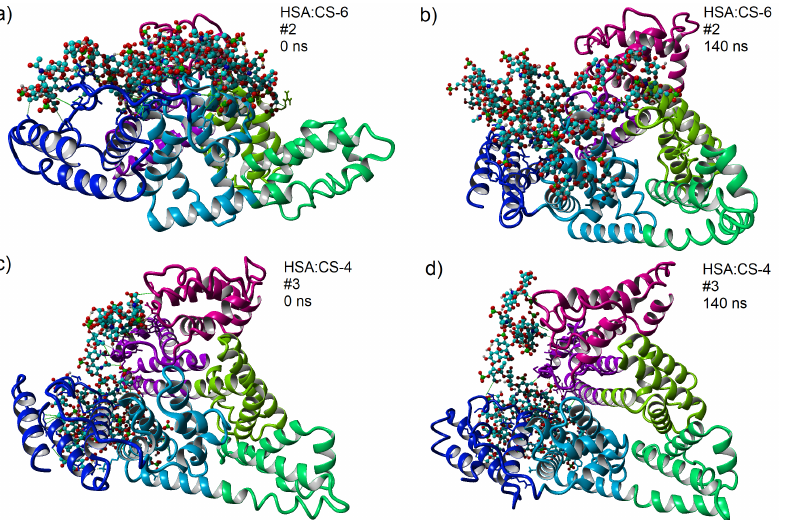
Figure 5. 3D structures of HSA:CS-6 ( a , b ) and HSA:CS-4 ( c , d ) complexes for the strongest bound complexes after MD in CaCl 2 solution (solution is transparent on the picture). HSA domains are colored as follows: IA-pink, IB-violet, IIA-light green, IIB-green, IIIA-light blue, and IIIB-blue. In CS-4 and CS-6, light blue atoms represent carbon; dark, blue nitrogen; red, oxygen; green, sulfur; and white, hydrogen. Snapshots are taken using YASARA software ( a , c ) before and ( b , d ) after 140 ns of MD simulations [47]. After a closer look at these pictures, green and pink lines can be observed, which show HP and ionic intermolecular interactions, respectively, and also yellow lines, which show intramolecular HBo inside